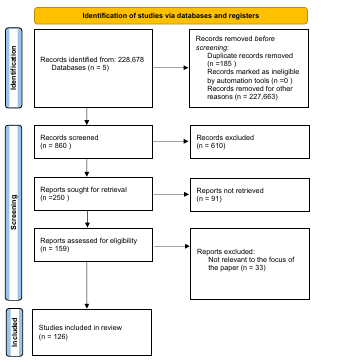
Figure 1. PRISMA chart of the literature flow of the study.